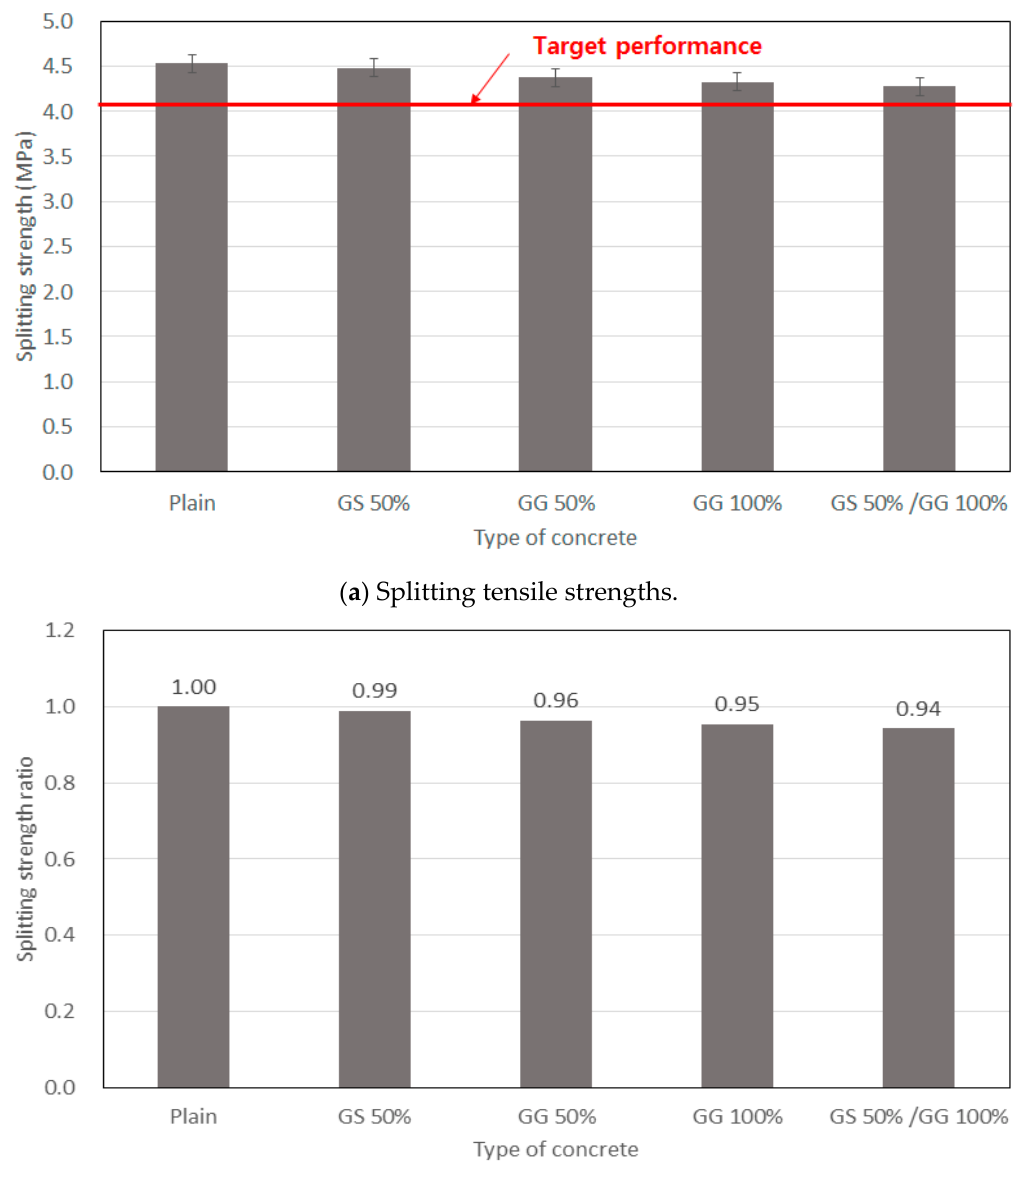
Figure 6. Test results for splitting tensile strength.